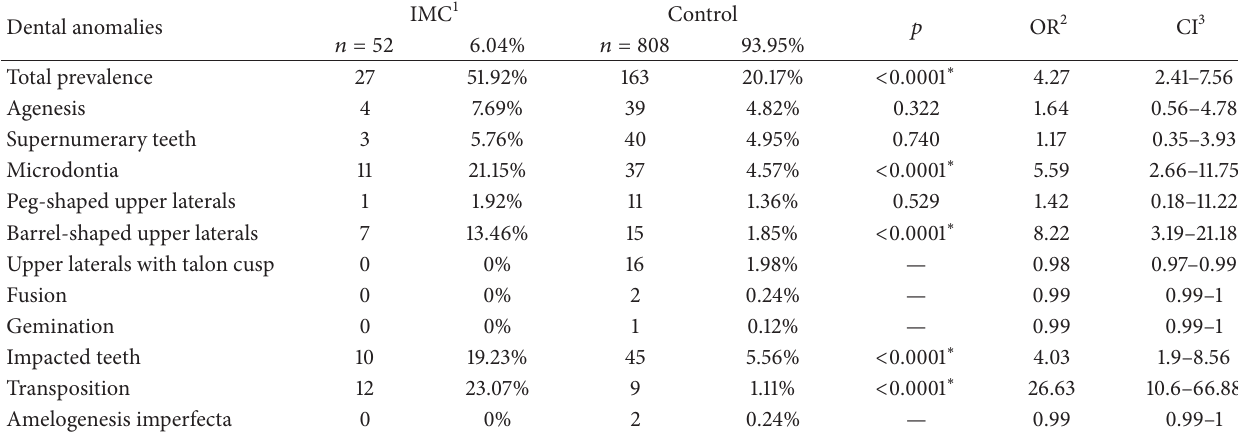
Table 1: Prevalence and distribution of dental anomalies by group; total sample size =